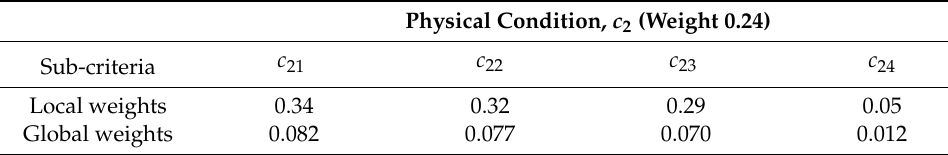
Table 9. Weights of sub-criteria related to the physical condition.